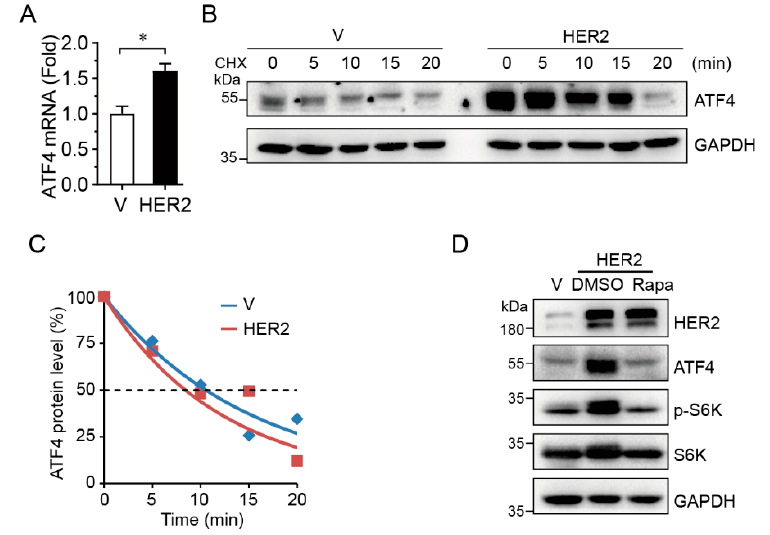
Figure 2. HER2 upregulates ATF4 expression at both transcriptional and translational levels. MCF10A-HER2 cells were subjected to Q-PCR analyses ( A ), protein half-life assay and the relative ATF4 protein expression levels were quantitated as described in the Materials and Methods ( B – C ), or were treated with or without rapamycin (100 nM) prior to Western blot analyses ( D ). The Q-PCR data were derived from three independent experiments; *: p < 0.05.